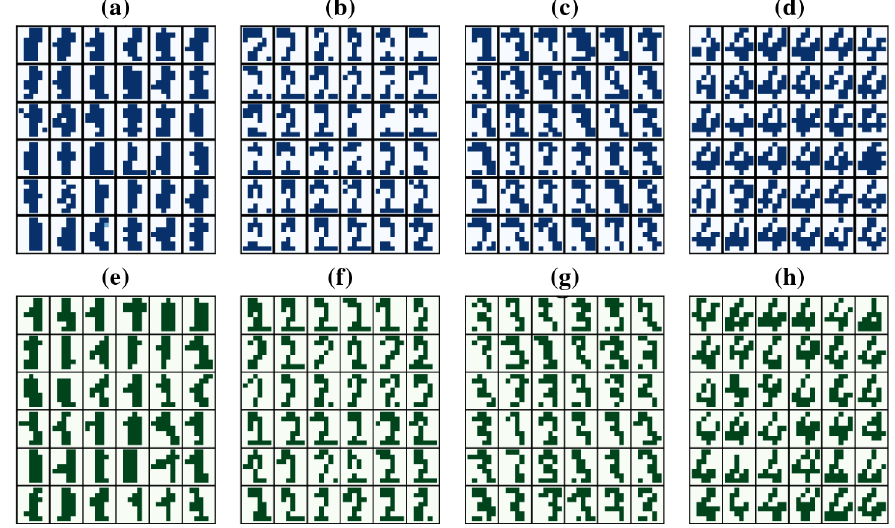
FIG. 6. Visual Turing test(a) – (h). The reader is invited to distinguish between human-generated pictures from the test set and machine- generated pictures sampled from the model. Columns identify classes one to four; rows identify the source — human or machine. The solution is given in Ref.